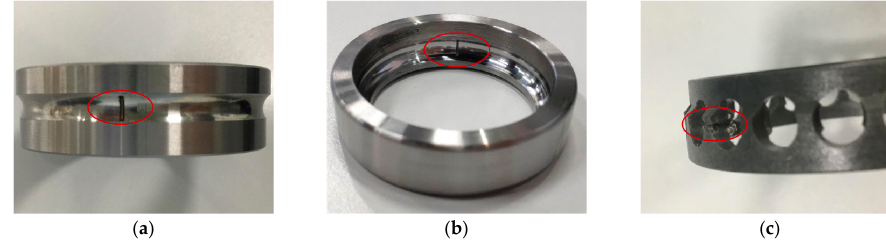
Figure 13. ( a ) Inner race fault; ( b ) outer race fault; ( c ) retainer broken fault. Table 9. Descriptions of various working conditions.